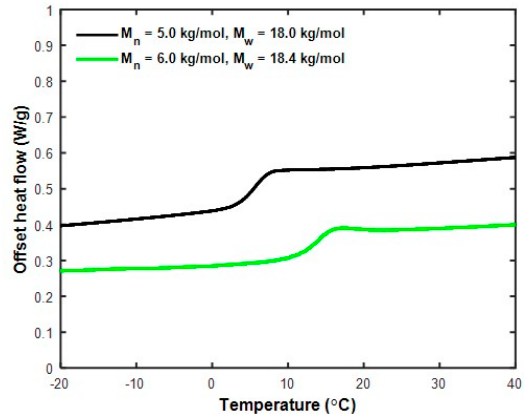
Figure 4. Second DSC heating traces of the polymer containing 100% BP-C 2 as dicarboxylic acid, directly after synthesis (black line) and after immersion into demineralized water for one week followed by drying in vacuo (green line).